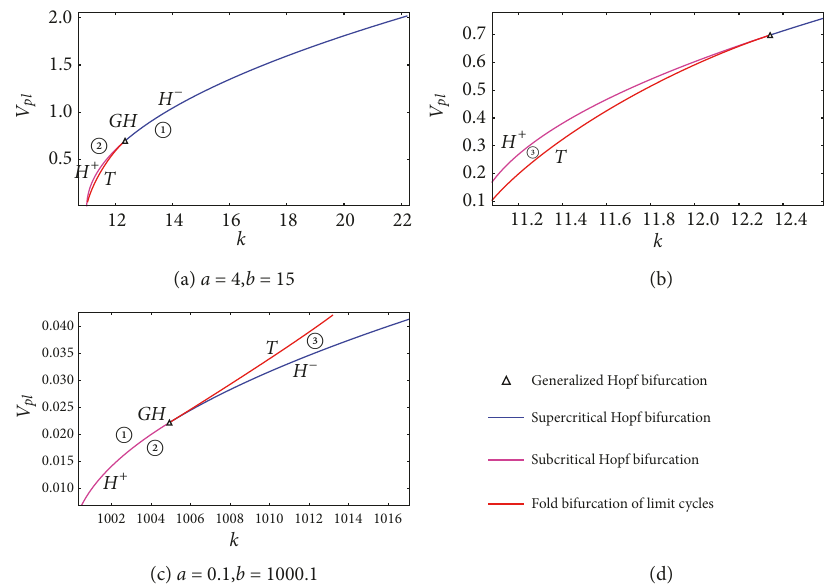
Figure 3: Bifurcation diagrams of system (12) by AUTO. (b) Partial enlargement of (a); (d) meanings of the symbol and curves.